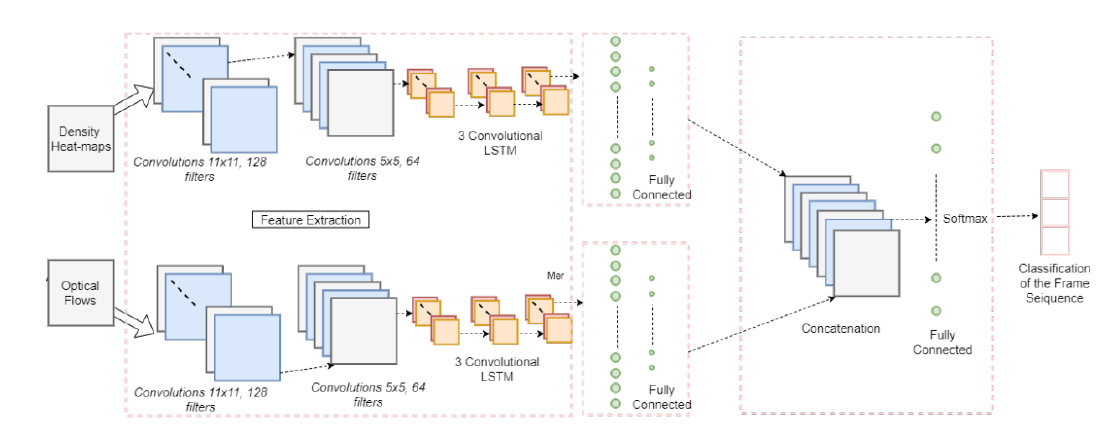
Figure 8. Abnormal event detection network from [79].